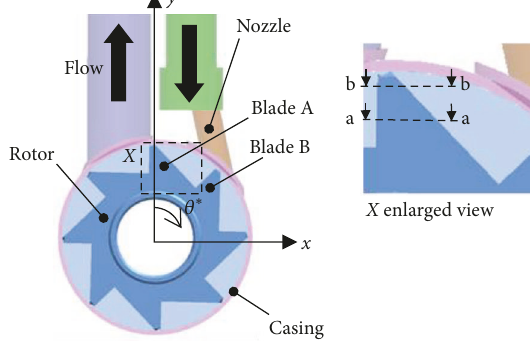
Figure 8: Turbine section region.